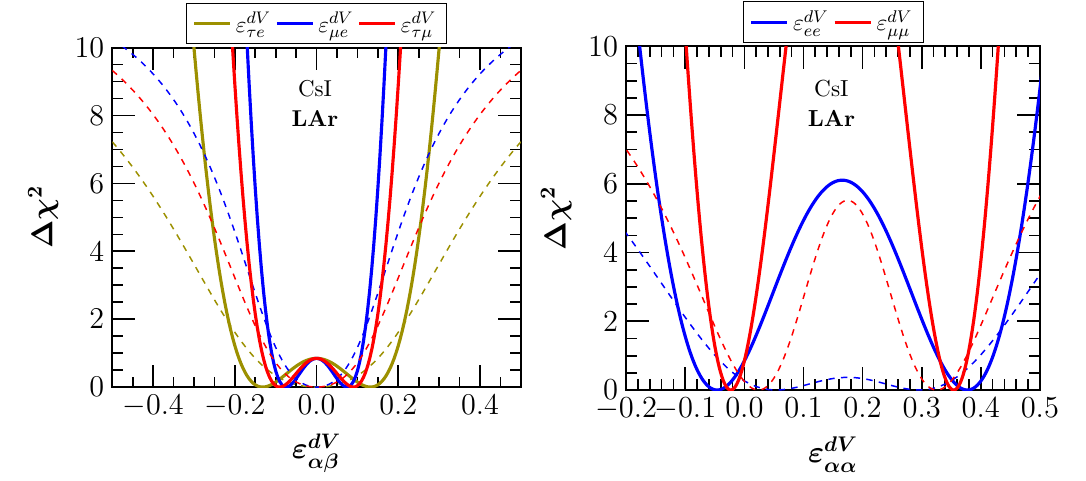
Figure 3 . Sensitivity of the new CENNS-10 LAr results (solid lines) and the (cid:12)rst COHERENT-CsI measurements (dashed lines) to the (cid:13)avor changing (left) and non-universal (right) NSI